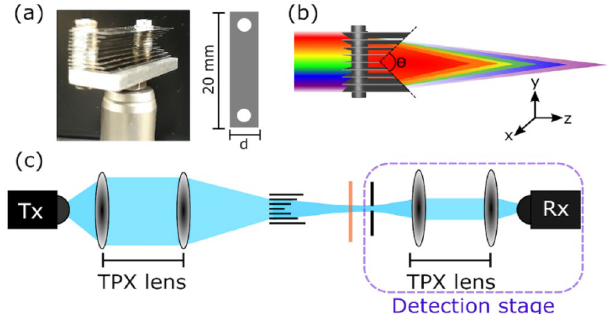
Figure 1. ( a ) Photo of the triangular-shaped axicon and dimensions. ( b ) False color diagram representing the variation of the focal length as function of the frequency. ( c ) Experimental setup for the investigation of focal depth and cross-section properties of the metallic axicon. The blue regions denote THz light. The sample is represented by the orange